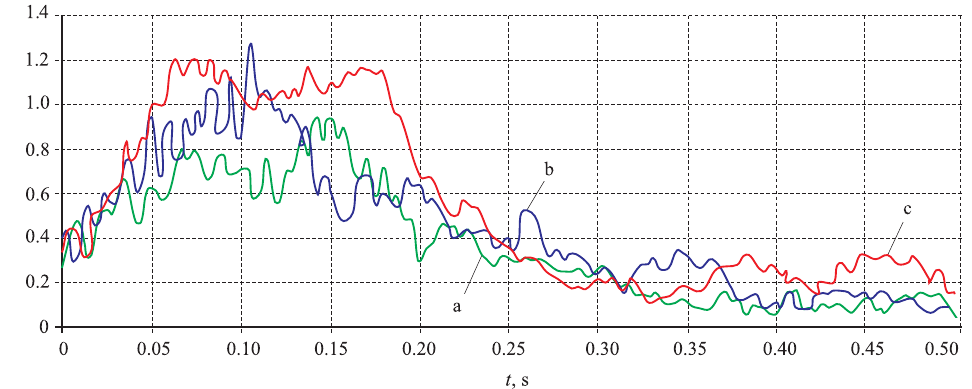
Fig. 6. ASI parameter vs time plot: a – TB11 test; b – 20°, 130 km/h; c – 40°, 100